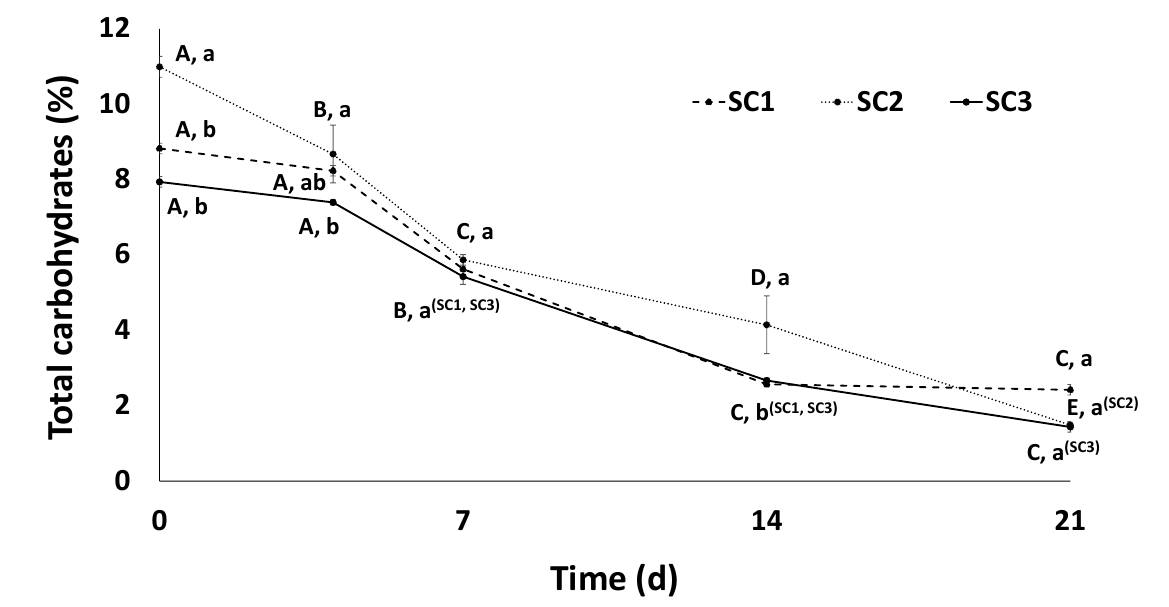
Figure 3. Evolution of total carbohydrate content (%) in ST kombuchas fermented using SCOBYs 1, 2, and 3 (SC1, SC2, SC3). Different letters show statistical significance ( p ≤ 0.05) between different fermentation days for the same SCOBY (A–E) and between different SCOBYs for the same fermentation day (a–b).